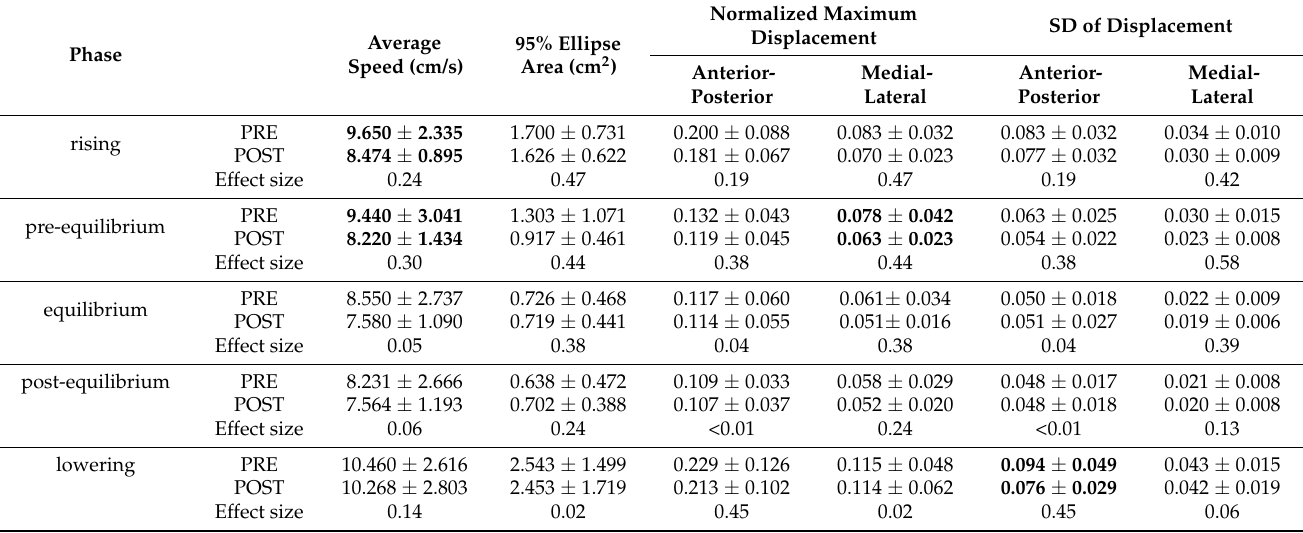
Table 4. COP parameters during releve en demi-pointe (mean ±